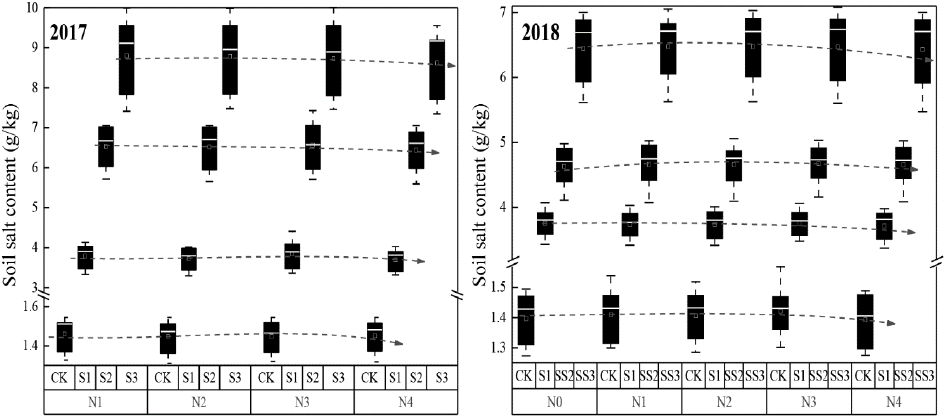
Figure 5. Changes in soil salt content during different growth stages for the different treatments. The upper and lower ends of the black boxes represent the 25th and 75th percentiles, respectively, while the white lines inside the box represent the median values, and the small open squares in the middle represent the mean values.